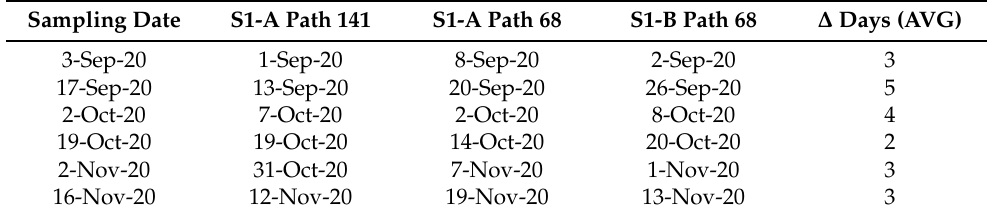
Table 2. Field campaign and Sentinel-1 acquisition